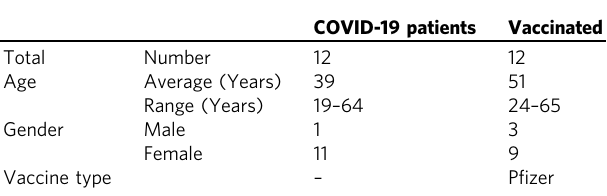
Table 2 Demographic information for participants in antibody neutralization study.